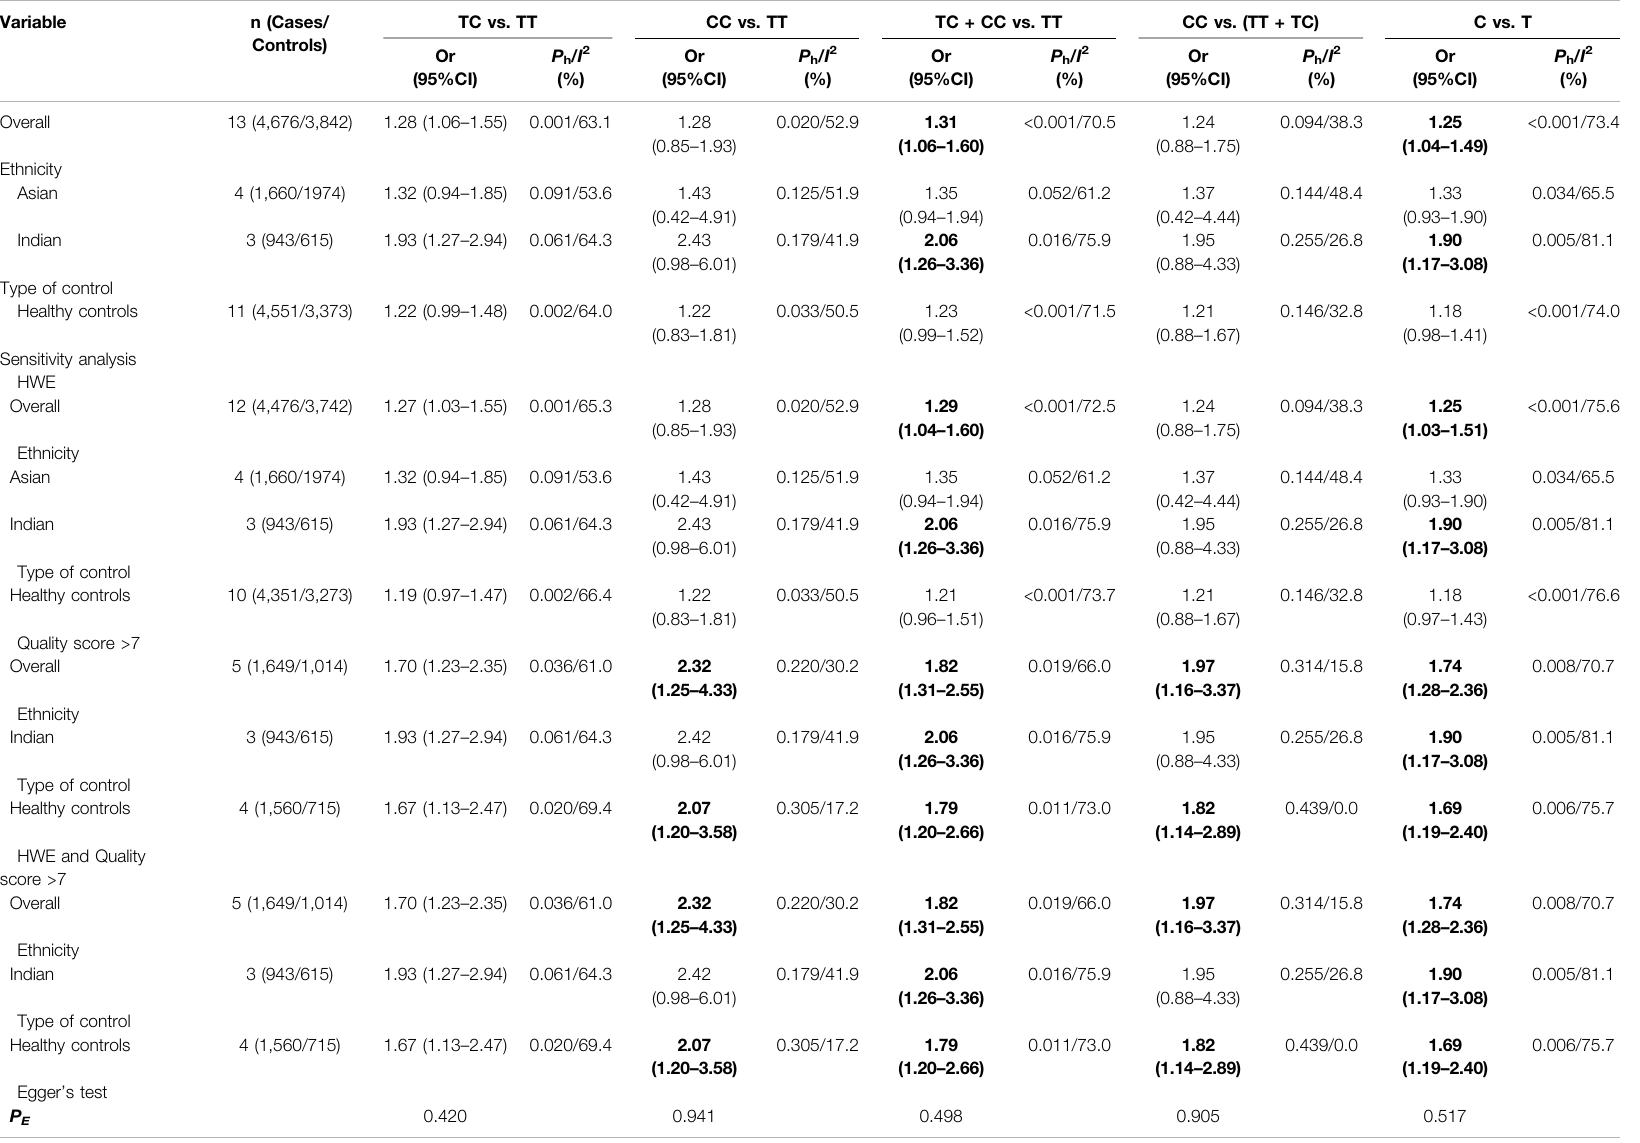
TABLE 8 | Meta-analysis of the association of eNOS T786C polymorphism with risk of T2DM.